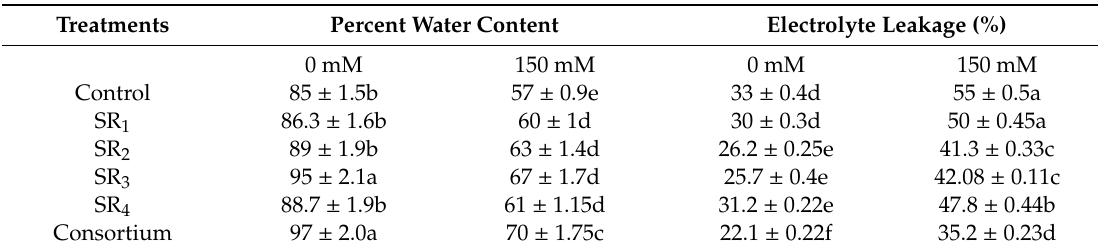
Table 4. E ff ect of inoculation of halotolerant PGPR strains on the leaf water content and electrolyte leakage of wheat plants grown under salinity stress.